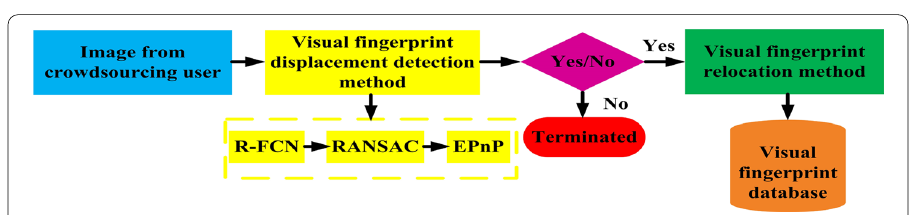
Fig. 2 The overflow of the crowdsourcing visual fingerprint updating